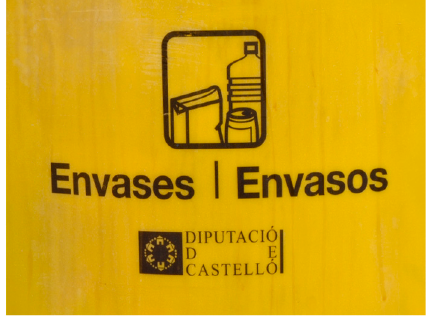
Figure 9. Benasal: Bilingual sign on a plastic recycling container .